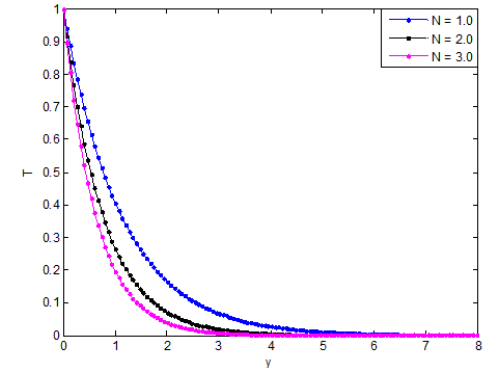
Figure 20. Effects of buoyancy ratio on the temperature distribution